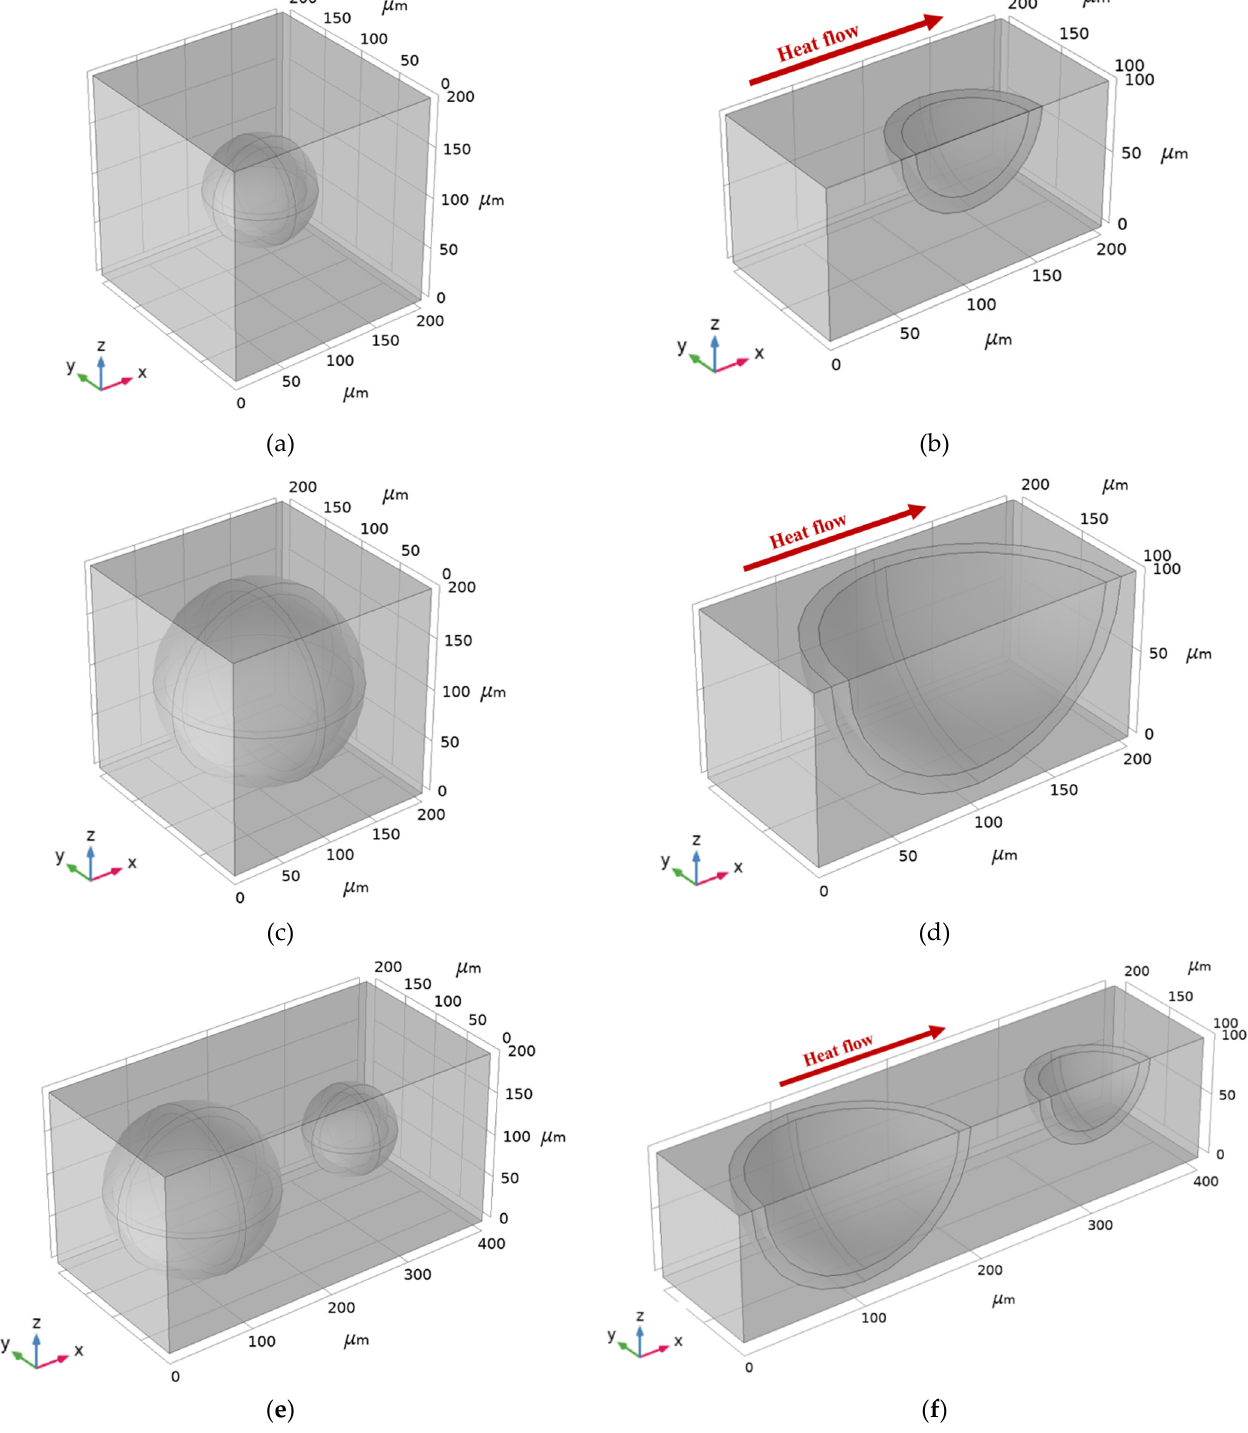
Figure 6. Model of composites: ( a ) Composite 1 with ∅ 80 − ∅ 100 µ m cenosphere inside of the 200 × 200 × 200 µ m cube; ( b ) One-quarter of the model of Composite 1; ( c ) Composite 2 with ∅ 160 − ∅ 180 µ m cenosphere inside of the 200 × 200 × 200 µ m cube; ( d ) One-quarter of the model of Composite 2; ( e ) Composite 3 with ∅ 80 − ∅ 100 µ m and ∅ 160 − ∅ 180 µ m cenospheres inside of the 400 × 200 × 200 µ m cube; ( f ) One-quarter of the model of Composite